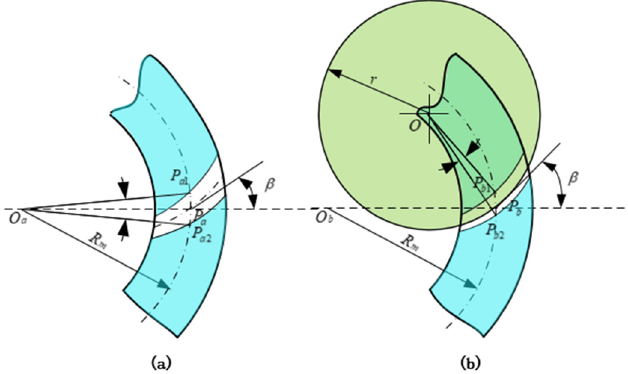
Fig. 1. Flank lines on the pitch cone. (a) Tooth blank in single- side method. (b) Tooth blank in Comparing Figure 1, a difference of tangent angle occurs and can be expressed as